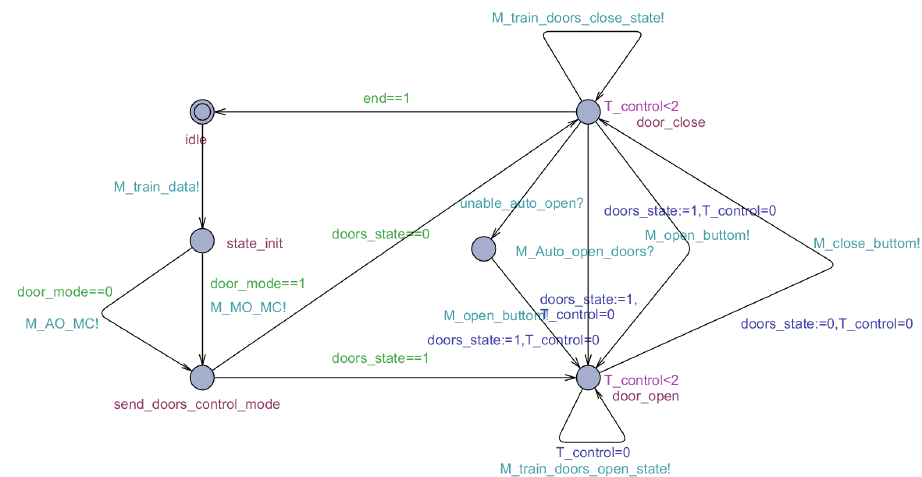
Figure 13. The train model of the linkage control scenario of train doors and platform doors.